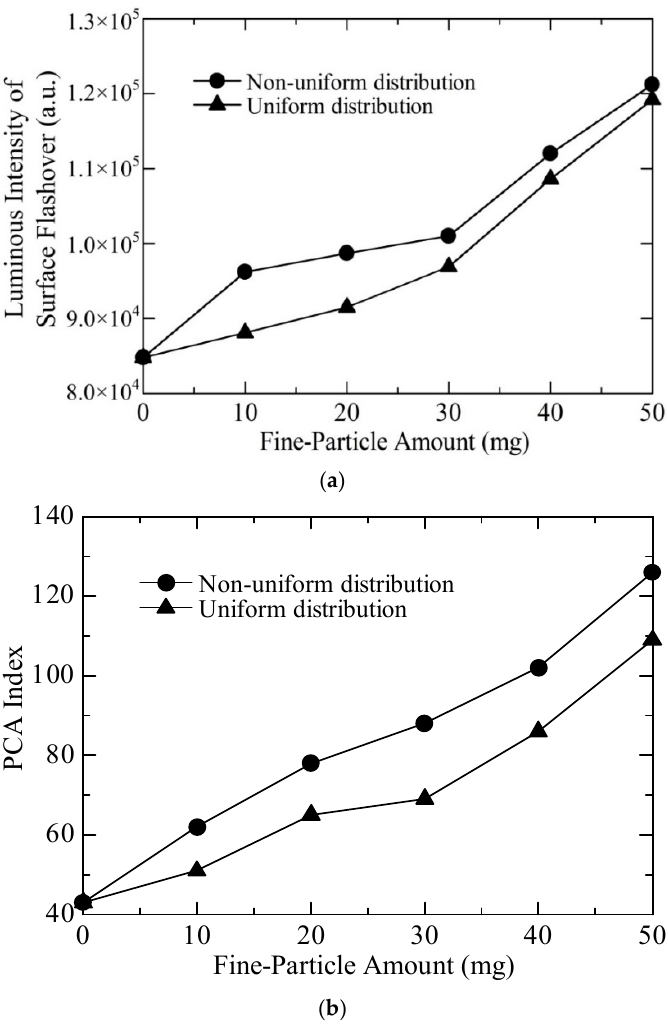
Figure 9. Discharge characteristic analysis in relation with fine-particle amount with a particle size of 38 μ m. ( a ) Luminous intensity of surface flashover; ( b ) PCA classification.